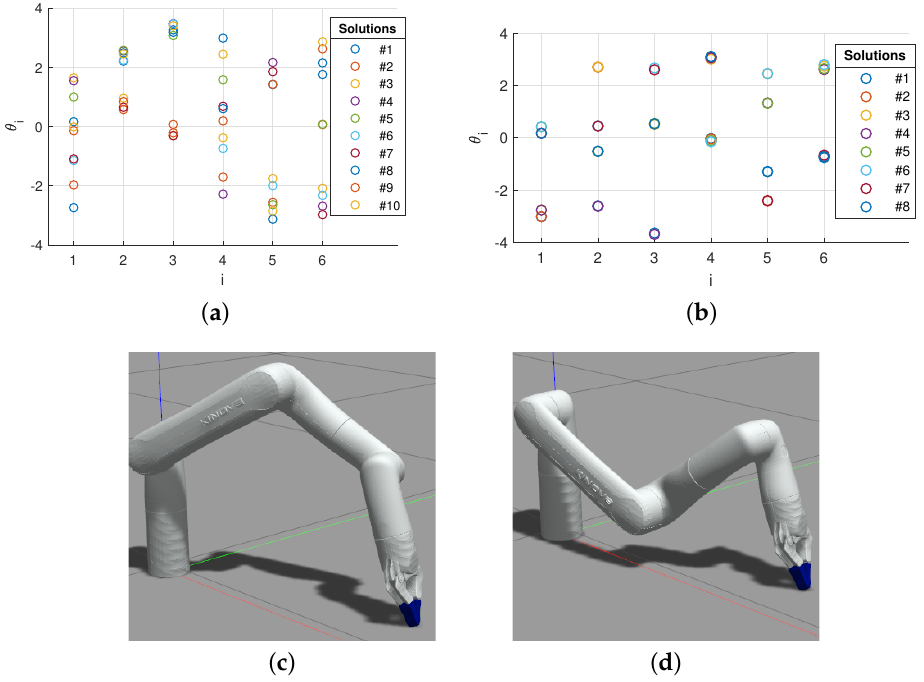
Figure 9. Possible postures from the examples. ( a ) Solutions to example no. 1; ( b ) solutions to example no. 2; ( c ) Ex. no. 2: solution no. 6; ( d ) Ex. no. 2: solution no. 8.